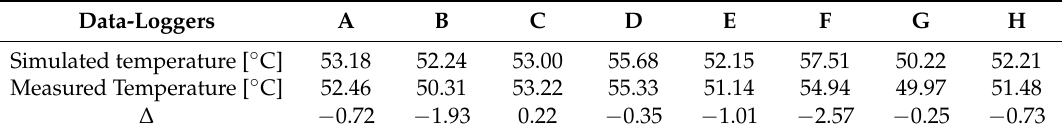
Table 5. Measured and simulated temperatures at the same points of the floor between 12:00 a.m. and 6:00 a.m. on 26 April 2014 and related temperature